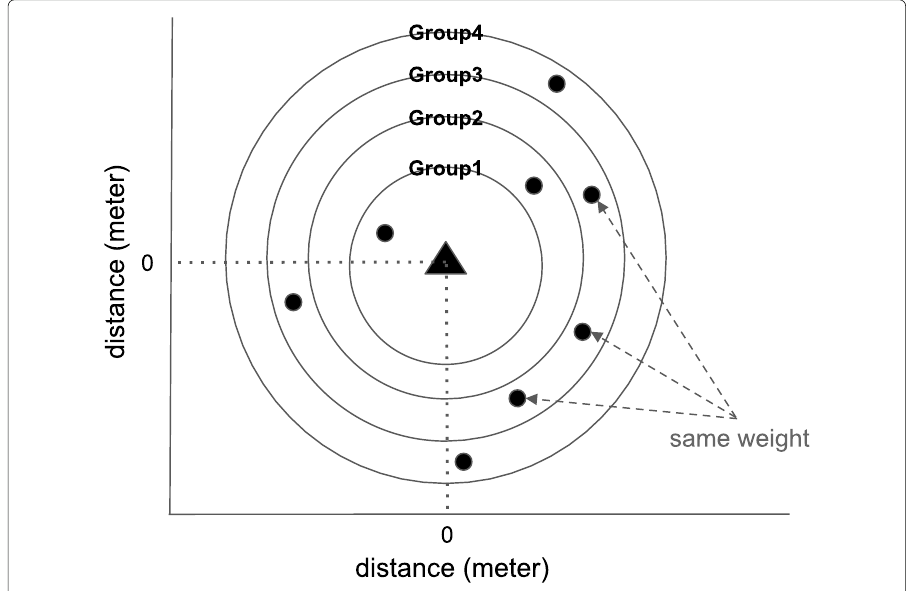
Fig. 5 Group by distance between terminal and